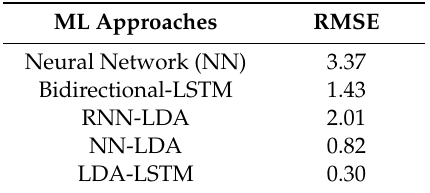
Table 12. Evaluation Metrics for Applied Machine Learning Approaches.